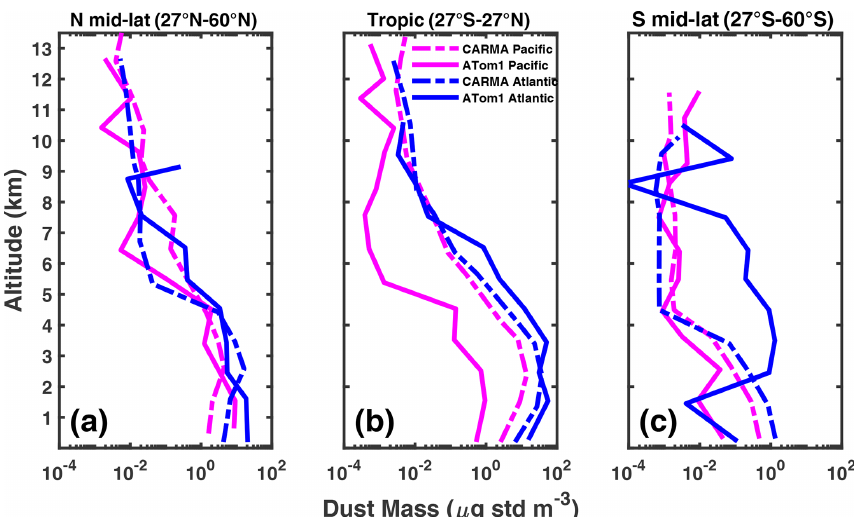
Figure 5. Simulated (long dashed line) and measured (solid line) vertical profiles of the dust concentrations during the ATom-1 field cam- paign. Both model and observations are sampled along the flight track. The profiles are averaged over the Pacific Ocean (pink) or Atlantic Ocean (blue) in the Northern Hemisphere (NH) mid-latitudes (27–60 ◦ N; a ) and tropics (27 ◦ S–27 ◦ N; b ), and in the Southern Hemisphere (SH) mid-latitudes (27–60 ◦ S; c